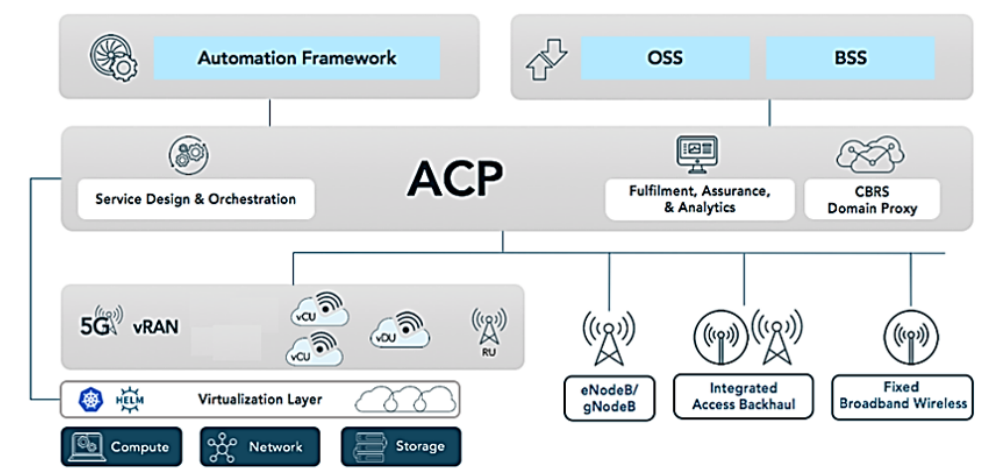
Figure 15. ACP—Airspan Control Platform. Based on